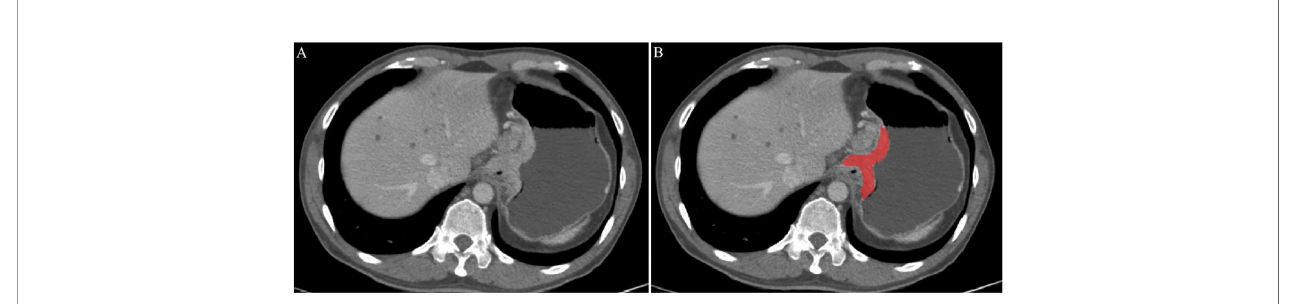
FIGURE 1 | An example of manual segmentation in Adenocarcinoma of the esophagogastric junction (AEG). (A) Localized thick wall of esophagogastric junction with enhancement is observed on the portal venous phase computed tomography (CT) image; (B) Segmentation of the same axial